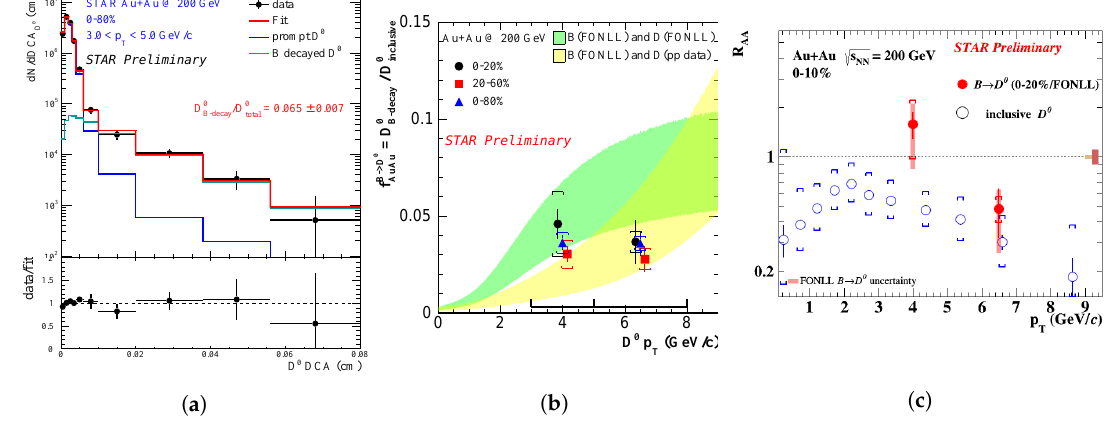
Figure 3. ( a ) DCA distribution of inclusive D 0 with a template fit including non-prompt and prompt D 0 . ( b ) fraction of non-prompt D 0 as a function of p T in different centralities compared to that for p + p collisions. ( c ) R AA of non-prompt and inclusive D 0 as a function of p T